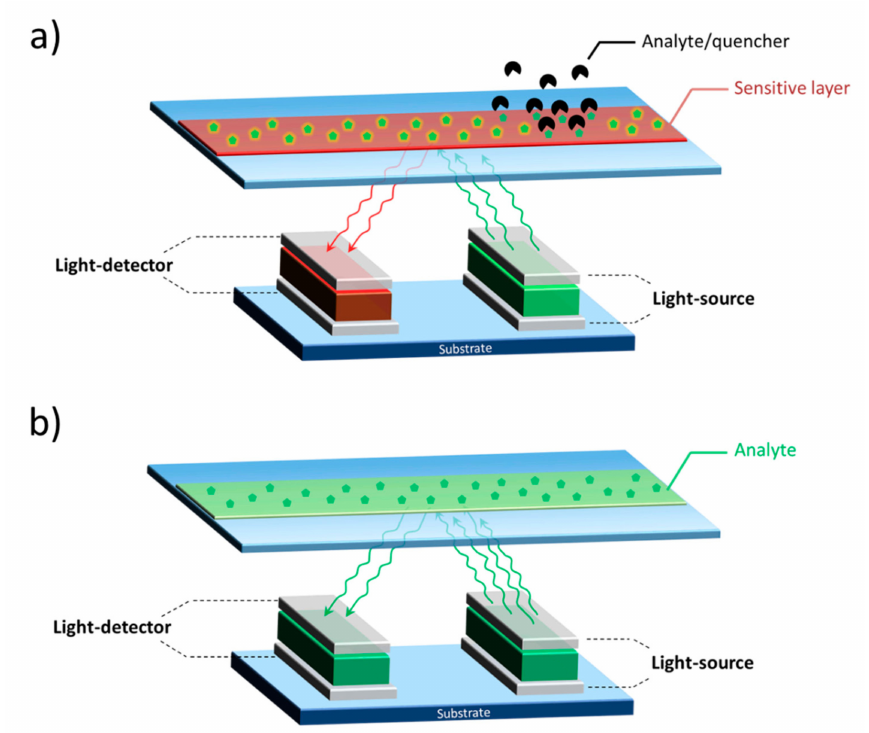
Figure 8. Schematic representation of optical sensors with a reflection-type architecture. The sensors comprise a light-emitting device, a light-sensitive device and a sensitive element, which acts as photoluminescent emitter sensitive to external quenchers ( a ) or absorber of the emitted light ( b ).